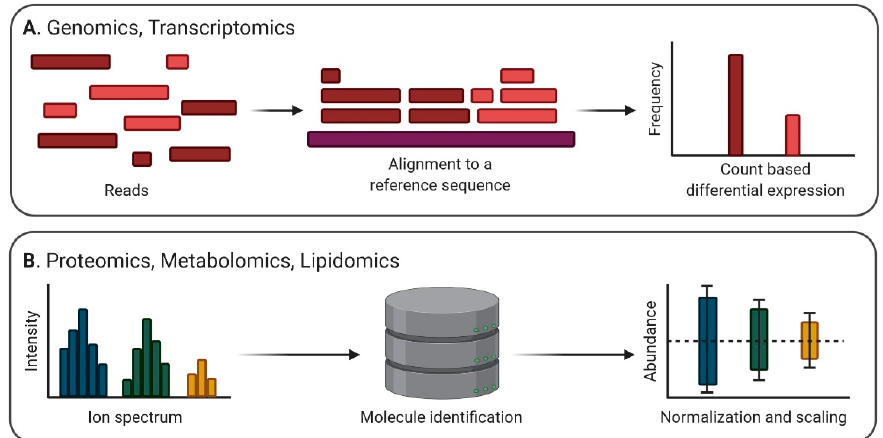
Figure 3. Preprocessing steps for omics data. For sequencing data, reads are curated and then aligned to a reference sequence; further on, gene and transcript quantification occurs through count-based methods ( A ). For mass spectrometry data, ion peaklists are mapped using database entries; then, identified molecule abundance is normalized for a final biomolecule profile ( B ). Figure created with BioRender.com.